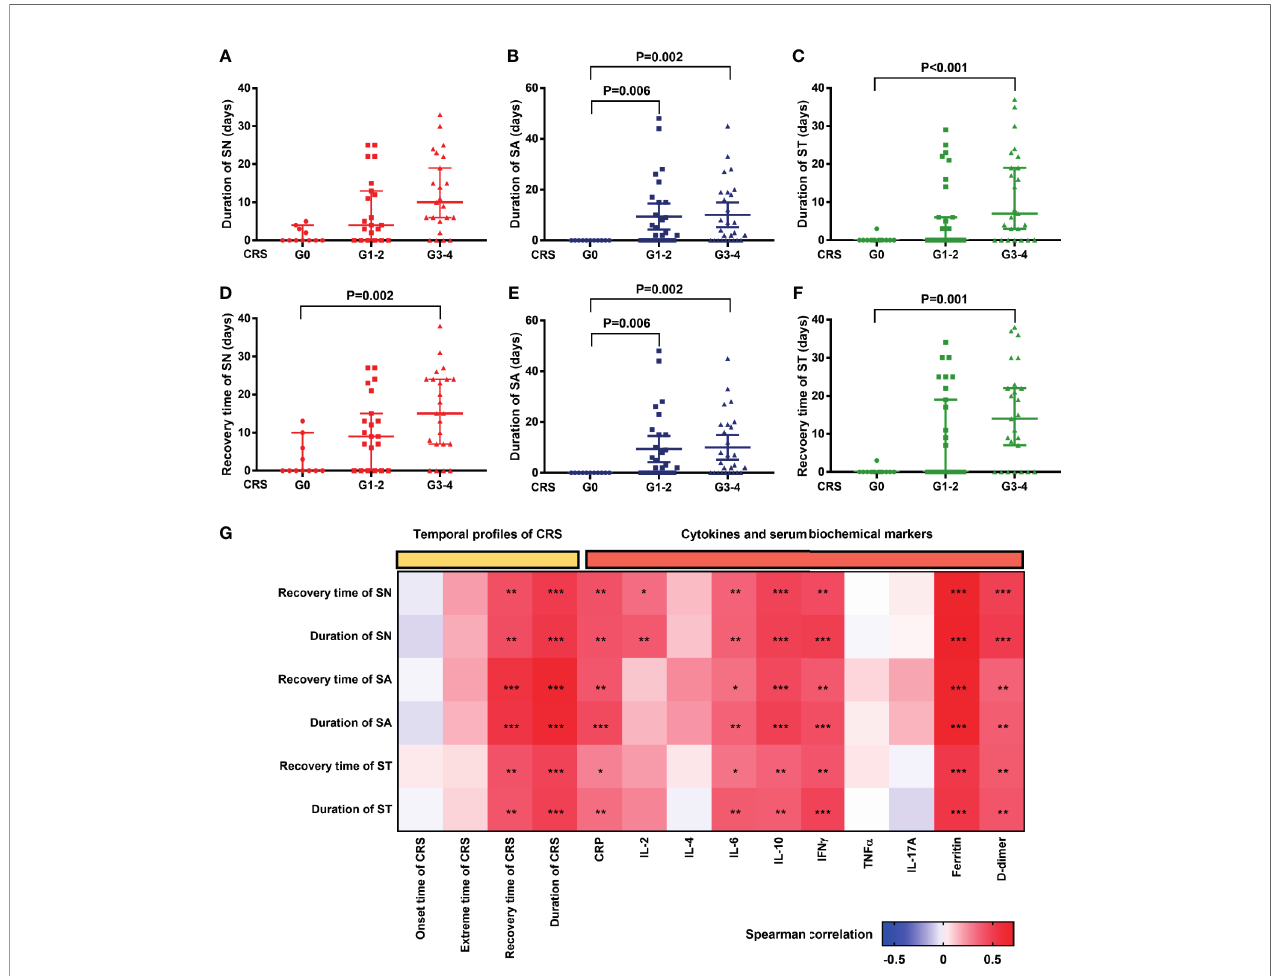
FIGURE 4 | Hematopoietic recovery after CAR-T cell infusion is signi fi cantly correlated with pro fi les of CRS and peak cytokines/serum biochemical markers associated with CRS. (A – C) The duration of severe cytopenia (median and 95%CI) is shown in patients without CRS or with mild or severe CRS. The duration of patients without cytopenia after CAR-T cell infusion was de fi ned as “ 0 ” . P values were tested using the Kruskal-Wallis test. (D – F) Recovery time from severe cytopenia (median and 95%CI) is shown in the aforementioned cohorts. The day of CAR-T cell infusion was recognized as the start points. P values were tested in the aforementioned way. (G) Correlation of pro fi les of severe cytopenia with pro fi les of CRS/serum markers. P values and r values were determined by Spearman correlation analysis. Serum markers were peak levels and log-transformed for correlation analysis. CRP, C-reactive protein; CRS, cytokine release syndrome; IFN, interferon; IL, interleukin; LDH, lactate dehydrogenase; SN, severe neutropenia; SA, severe anemia; ST, severe thrombocytopenia; TNF, tumor necrosis factor. ***P < 0.001, **P < 0.01, *P <